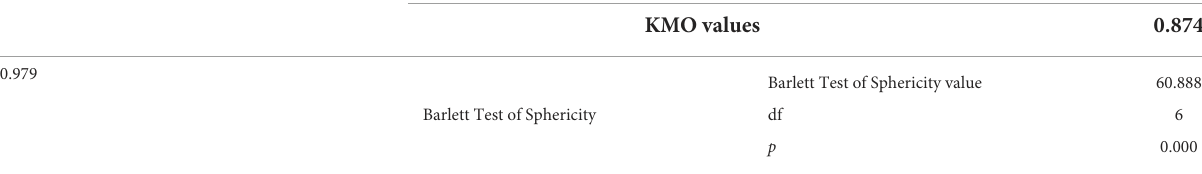
TABLE 1 Reliability coefficient test of PAD emotion